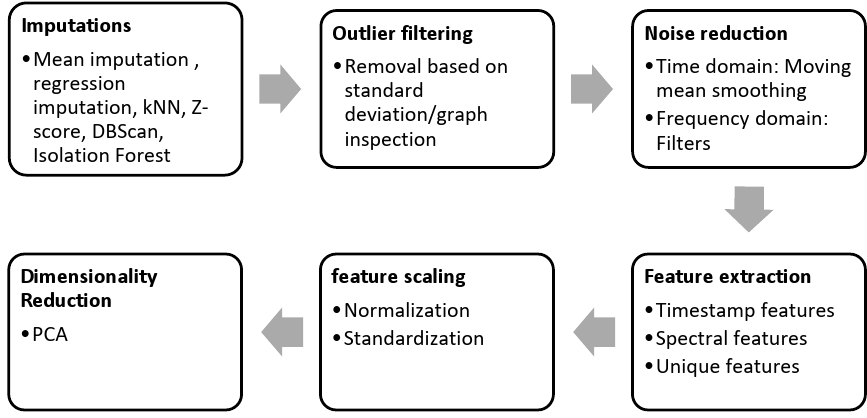
Figure 6. Data processing steps.